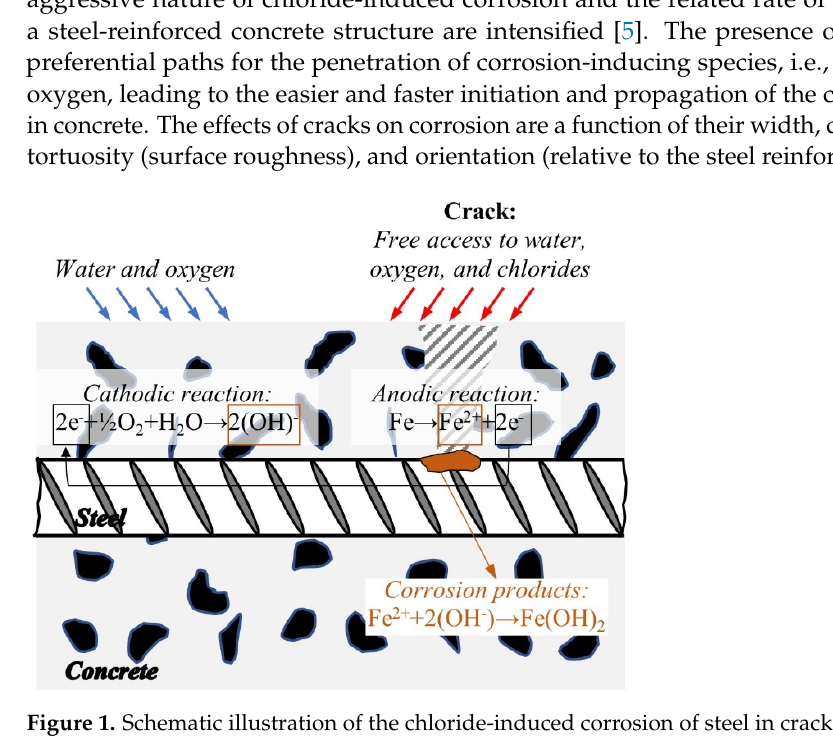
Figure 1. Schematic illustration of the chloride-induced corrosion of steel in cracked concrete.